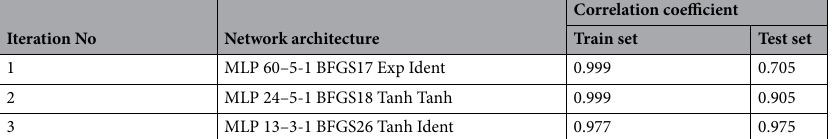
Iteration No Network architecture